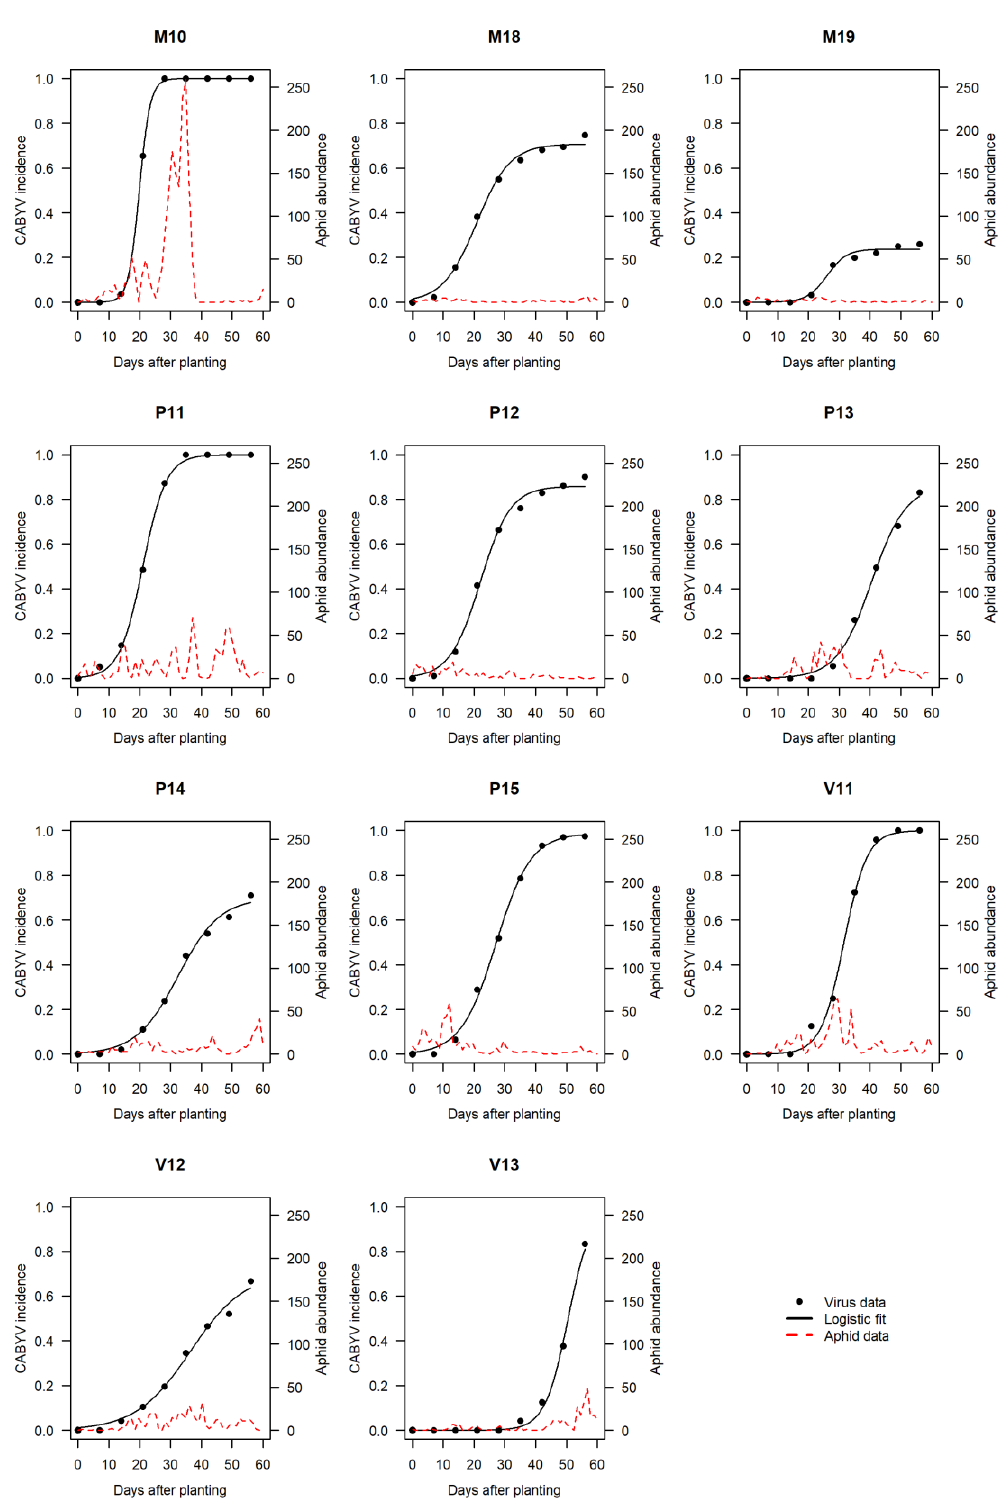
Figure 1. CABYV disease progress and aphid abundance assessed in melon crops in eleven field trials conducted in Avignon between 2010 and 2019. Black dots represent observed cumulative incidences (proportion of infected plants expressed as a ratio). Black solid lines are fitted curves (logistic model). Red dashed lines represent daily abundances of the pool of CABYV aphid vectors ( Aphis gossypii , Myzus persicae , Macrosiphum euphorbiae ).